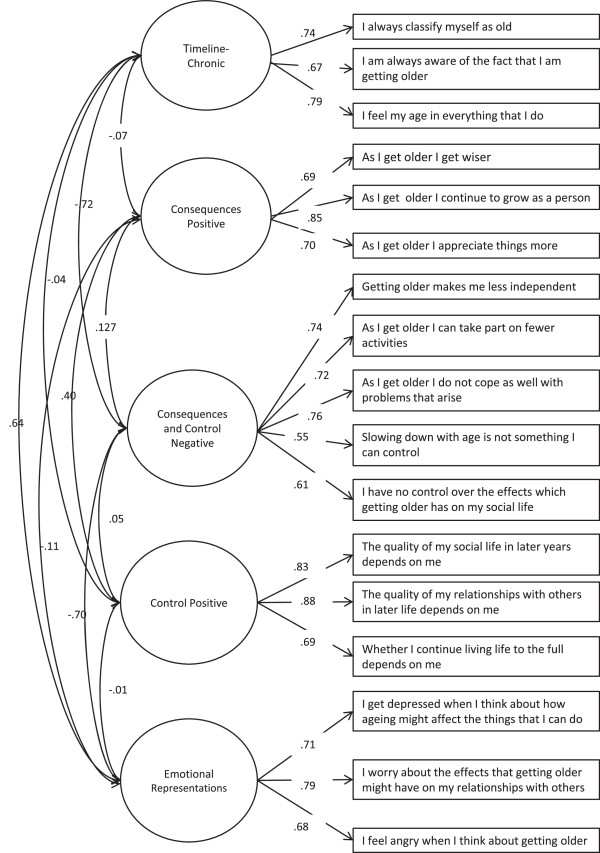
Unstandardised Parameters for Model 4.1.